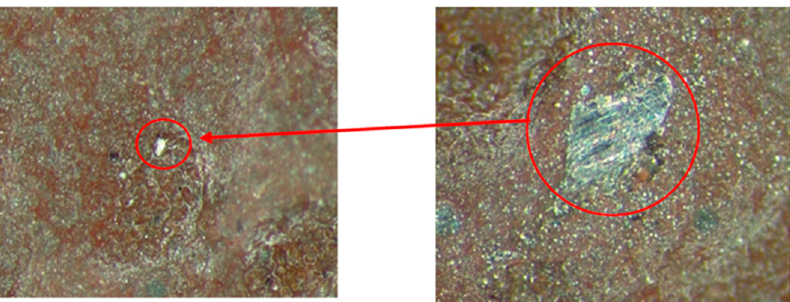
Figure 22. During the compaction process, aggregates wore through the zinc-rich epoxy primer and the waterproof bonding layer to reach the steel plate.